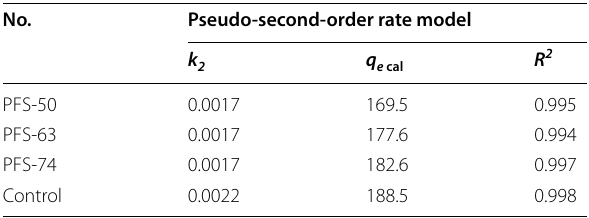
Table 4 Adsorption kinetics parameters fitted by the pseudo‑ second‑order rate model